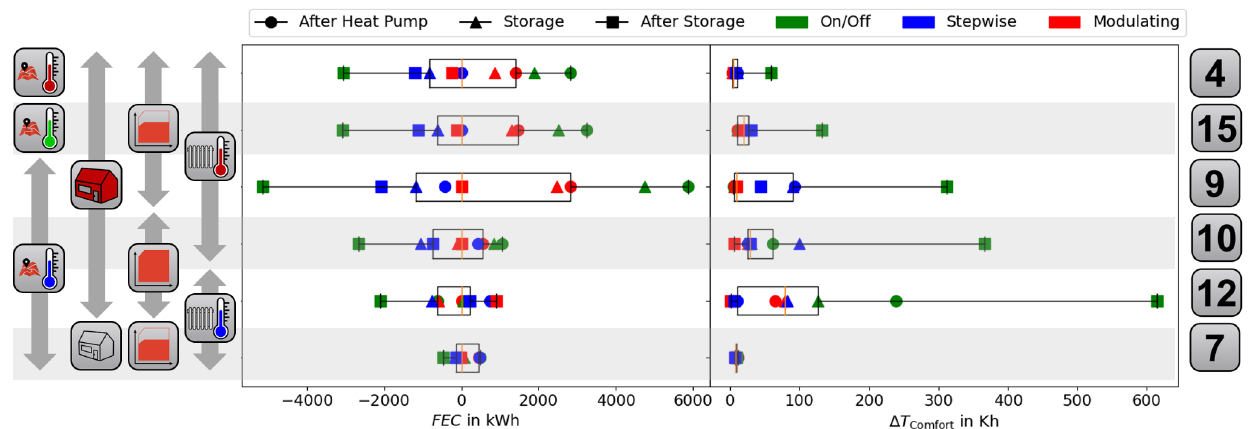
Figure 8. FEC saving potential and thermal comfort ∆ T Comfort for a selected set of scenarios. The On/Off BH after the storage yields discomfort in several cases. Furthermore, a non-refurbished building equipped with low temperature heating in cold weather results in discomfort in most scenarios. Refurbishment leads to higher comfort even for a low operational envelope. See Figure A3 for all